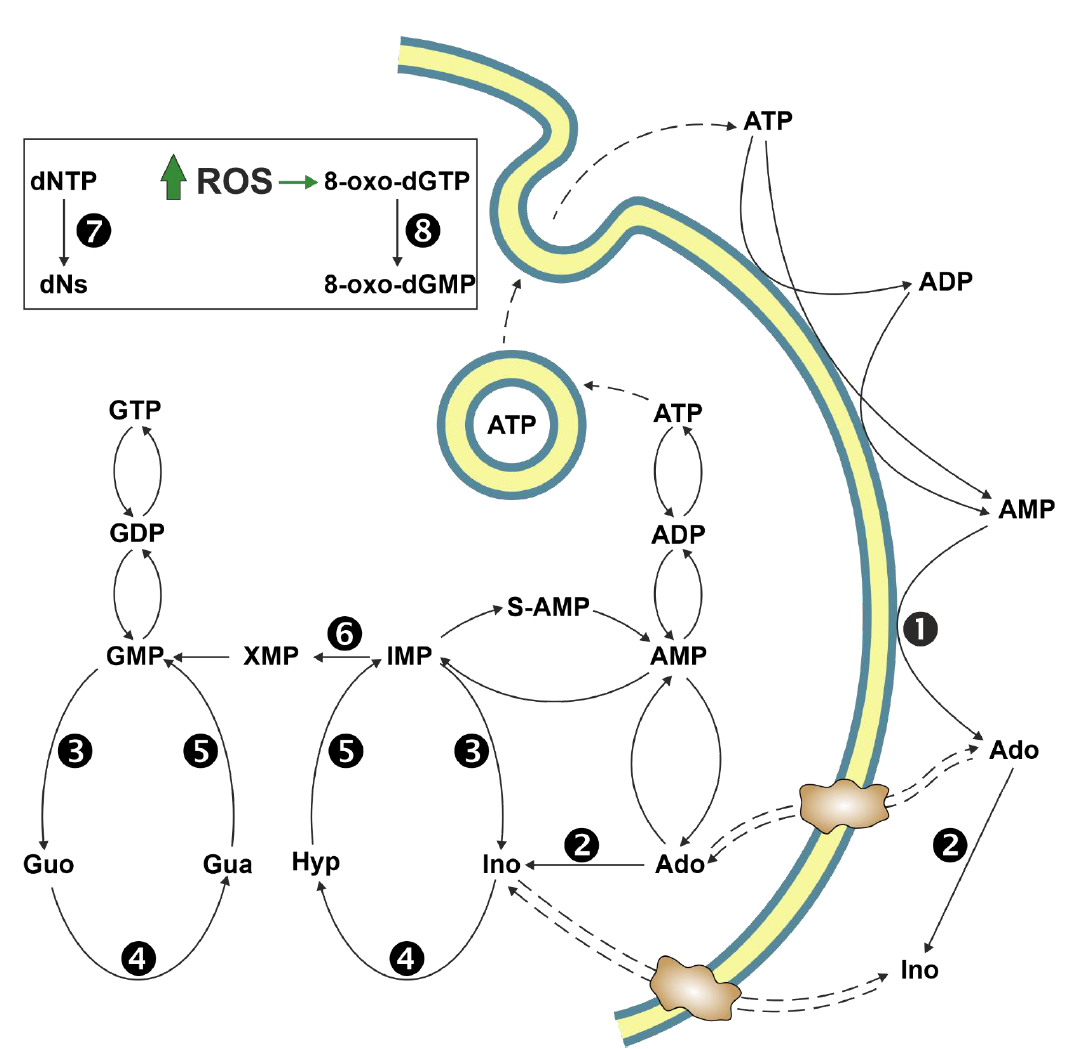
Figure 2. Pathways of purine metabolism. 1: Ectosolic 5′ -nucleotidase; 2: Adenosine deaminase; 3: